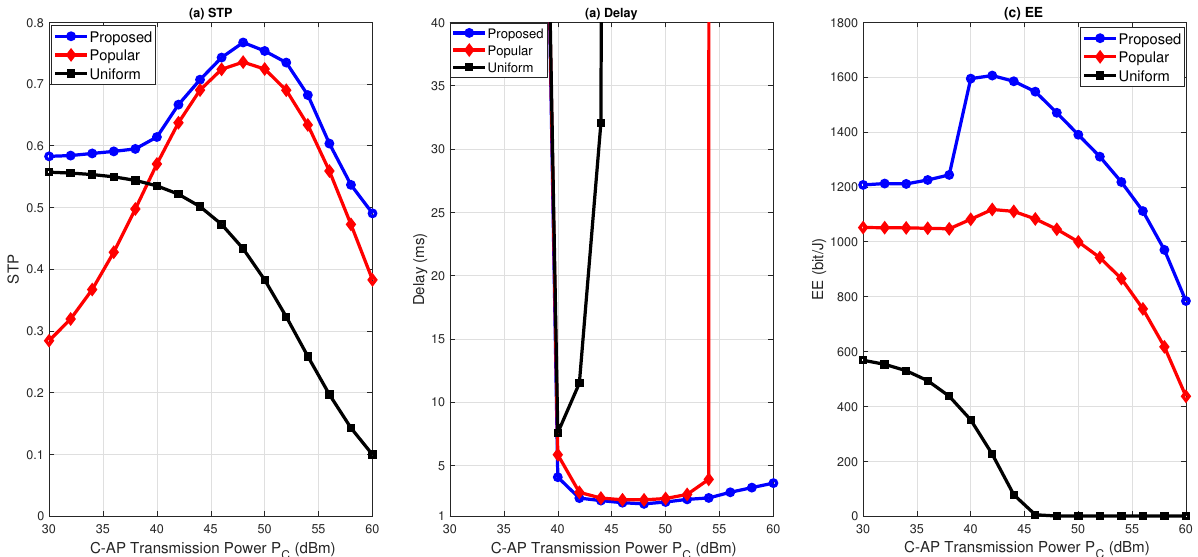
Figure 11. STP, delay, and EE versus F-APs’ transmission power when M = 20 contents, λ U = 0.1 users/m 2 , λ F = 0.01 F-APs/m 2 , λ C = 0.0001 C-APs/m 2 , R = 150 m, γ = 0.8, α = 4, P F = 30 dBm, P s = 37 dBm, ρ = 15.13, W F = 100 MHz, W C = 500 MHz, T = 1 ms, and τ = 0.1